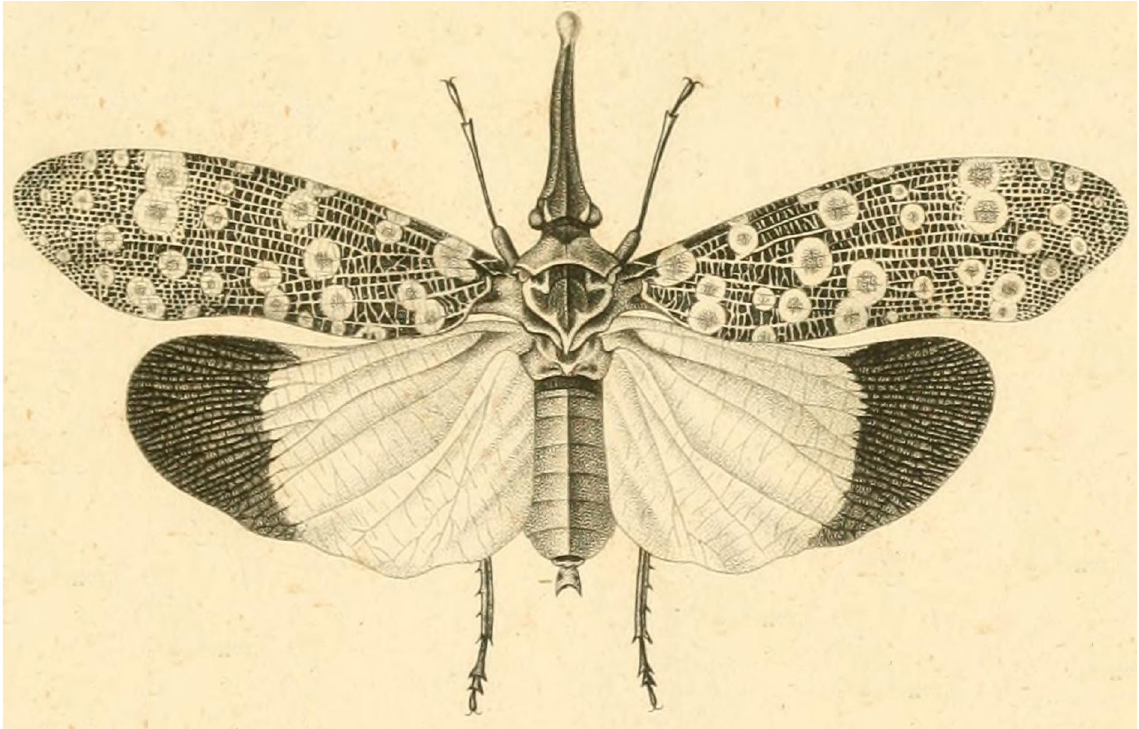
Fig. 8. Pyrops lathburii (Kirby, 1818), habitus illustration in Guérin-Méneville